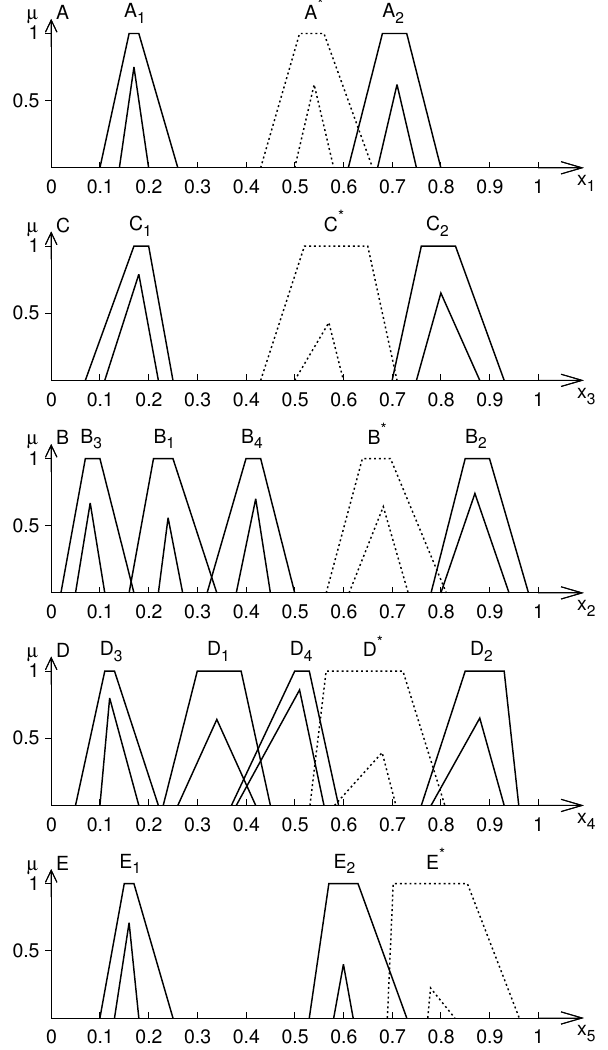
Figure 11. Interpolated results from rough-fuzzy interpolation (taken from